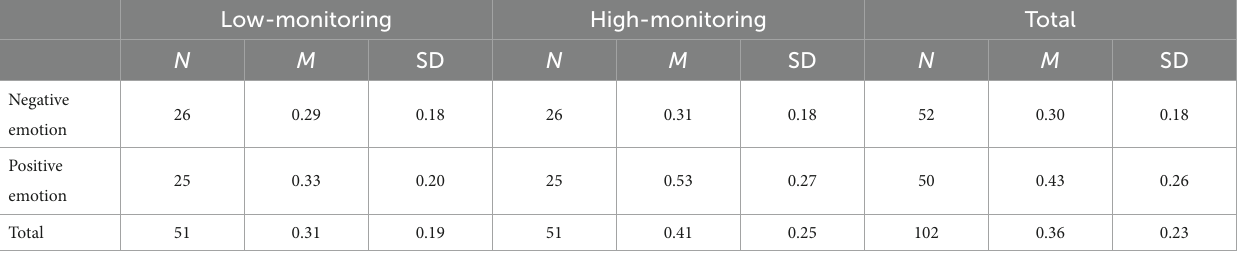
TABLE 2 Descriptive statistics of cognitive reflection test (CRT) accuracy between the high/low metacognitive monitoring ability groups and emotion manipulation in Experiment